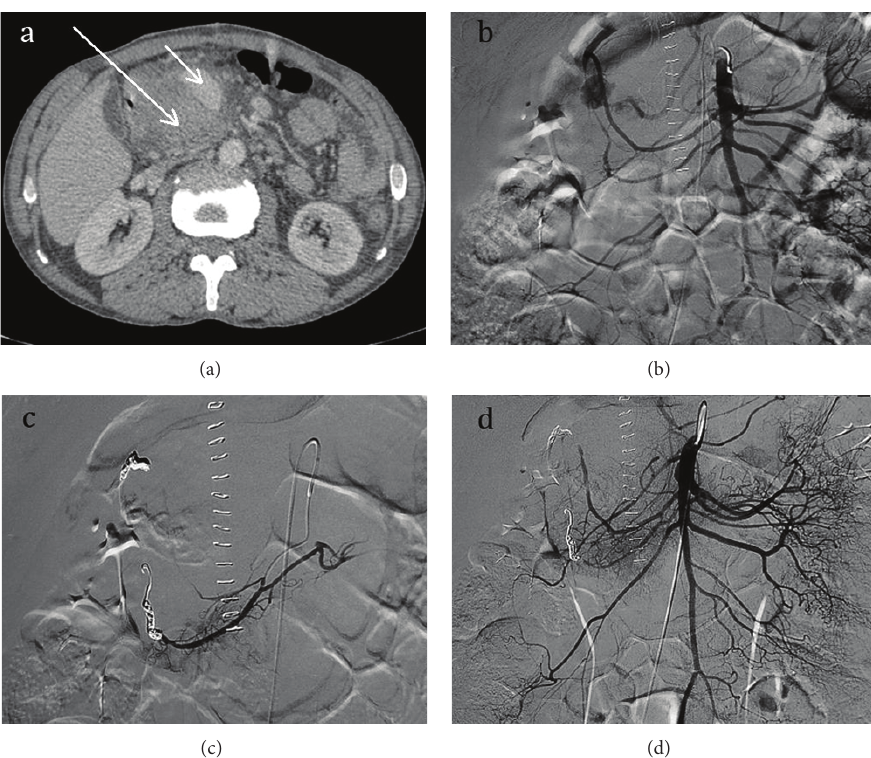
Figure 1: (a) Contrast-enhanced axial CT image shows a giant pseudoaneurysm of 8.3 × 7.5 cm in size originating from the gastroduodenal artery (long arrow). The intravenous contrast showed filling of the mass, certifying its vascular origin (short arrow). (b) Aortography shows the blood circulation of the aneurysm in continuity with the gastroduodenal artery. (c) Angiogram after selective coil-embolization of the gastroduodenal artery through the celiac trunk and the inferior pancreaticoduodenal artery, through the superior mesenteric artery. (d) Angiographic control confirmed the complete exclusion of the